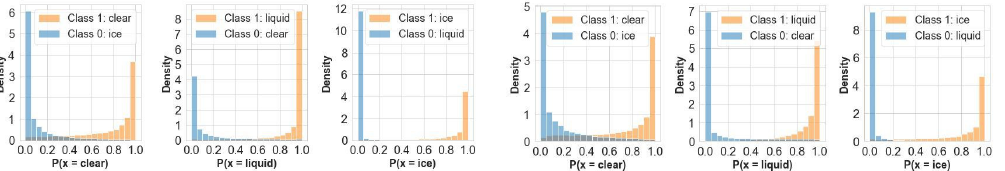
Figure 9. As in Figure 8 but for the synthetic AMSU-A/MHS validation dataset. 3.2. Detection Performance Using Observed Dataset To evaluate the NN model performances in a real context, we used a combined ob- servation dataset from the AMSU-A and MHS onboard MetOP-C. The considered datasets were downloaded from the EUMETSAT Earth observation portal in NetCDF format (Table 5). It consists of observations from the 15 AMSU-A channels and the 5 MHS channels dur- ing five full orbits. The distance between the AMSU-A and MHS footprints is negligible, being two sen- sors on the same platform. Each AMSU-A FOV is associated with nine MHS FOVs; the central one is concentric to the co-located AMSU-A FOV. As a reference for the NN cloud classification, the AVHRR cloud mask has been con- sidered. The spatial and temporal distances between AMSU-A/MHS and AVHRR/3 are negligible as the AVHRR/3 is placed onto the same spacecraft onboard MetOp-C. The cloud mask AVHRR is derived from clouds from the AVHRR extended (CLAVR-x). CLAVR-x developed at NOAA/NESDIS and UW/CIMSS generates cloud products in real time by using AVHRR data. Each AVHRR pixel has been classified into one of the follow- ing three classes: clear, liquid and ice. Collocation between AMSU-A and AVHRR uses an algorithm developed for atmospheric infrared sounder (AIRS) and moderate resolution imaging spectroradiometer (MODIS) data on NASA’s Aqua satellite [75] and is an exten- sion of the algorithms described in Li et al. [76]. This algorithm finds the closest AVHRR observation to the center of the AMSU-A footprint and performs an outward search to find all the AVHRR pixels falling within the AMSU-A footprint. Subsequently, for each AMSU-A pixel, the percentage of AVHRR pixels relative to the four classes contained within the AMSU-A pixel is calculated. According to the percentage of clear, liquid or ice, the AMSU-A FOVS is considered clear or affected by liquid or ice clouds. An AMSU-A